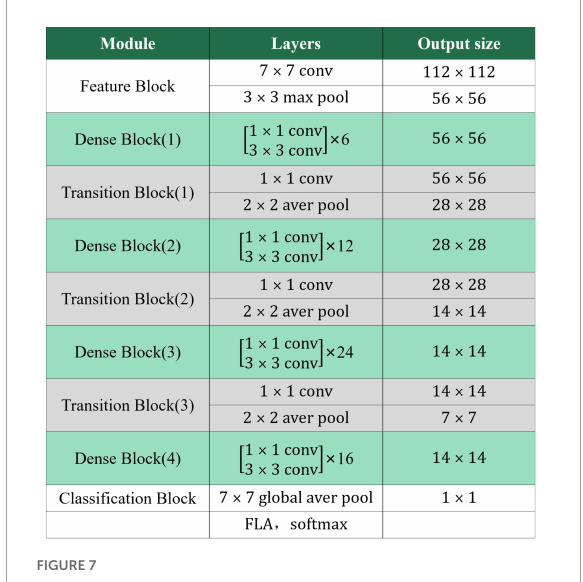
FIGURE7 Output parameters of each layer of